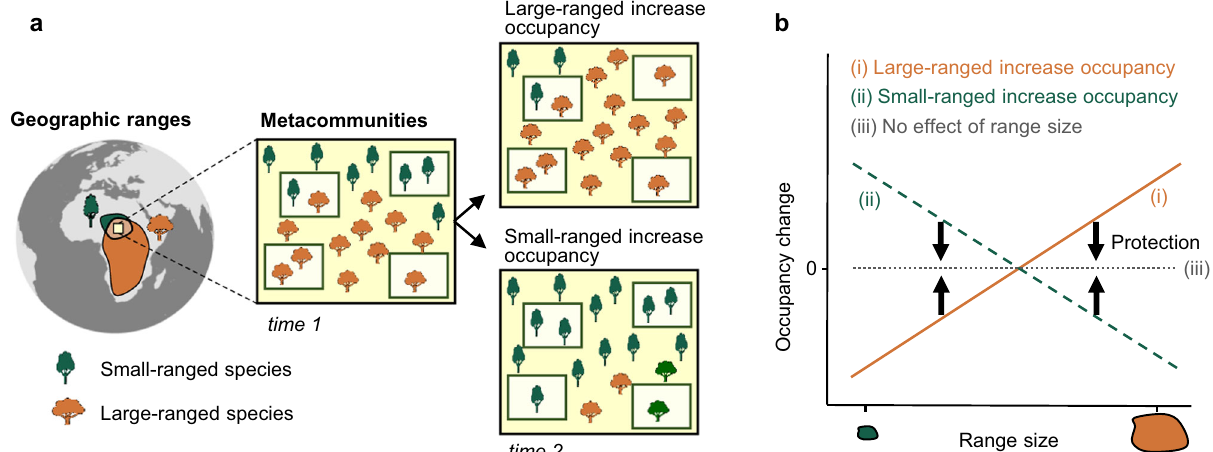
Fig. 1 | Hypothetical relationships between species ’ geographical range sizes andtemporalchangesofoccupancy.a Bycomparingmetacommunitiessurveyed in two time periods, we illustrate two contrasting scenarios about how twospecies with different range sizes might change their proportional occupancy through time: (i) large-ranged species increase occupancy but small-ranged species decreaseoccupancy;(ii)small-rangedspeciesincreaseoccupancybutlarge-ranged speciesdecreaseoccupancy.Otherscenarios,suchasbothsmall-andlarge-ranged species decreasing or increasing occupancy with differing magnitudes, are not